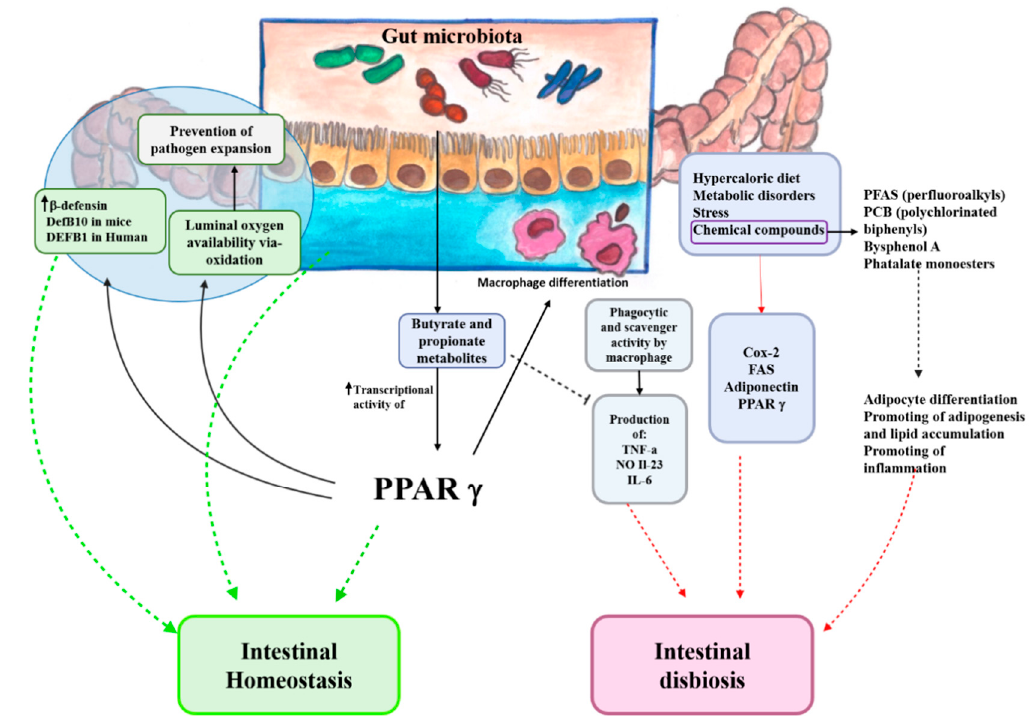
Figure 2. Synergistic action supported by the gut microbiota and PPAR γ in the maintenance of intestinal homeostasis. The microbial community produces short-chain fatty acids (SCFAs), such as butyric and propionic acid, which increase the transcriptional activity of intestinal PPAR γ , leading to a higher expression of β -defensins (DEFB1 in human and DEFB10 in mice) in the colon. Moreover, PPAR γ drives the energy metabolism to β -oxidation: the luminal oxygen availability decreases, preventing the expansion of facultative anaerobic pathogens. PPAR γ is also involved in macrophage activation and function, influencing the phagocytic and scavenging activity. Intestinal dysbiosis is the result of endogen and exogen factors. Among the external factors, hypercaloric diet, stress, metabolic disorders, and exposure to chemical compounds permit a state of low-grade inflammation to be established. The reasons are to be found in the altered expression of PPAR γ and other inflammation markers. Several chemical compounds may determine alteration in adipose tissue function. Since adipose tissue contributes to intestinal homeostasis, the impairment of PPAR γ activity may indirectly promote the onset of intestinal disorders.